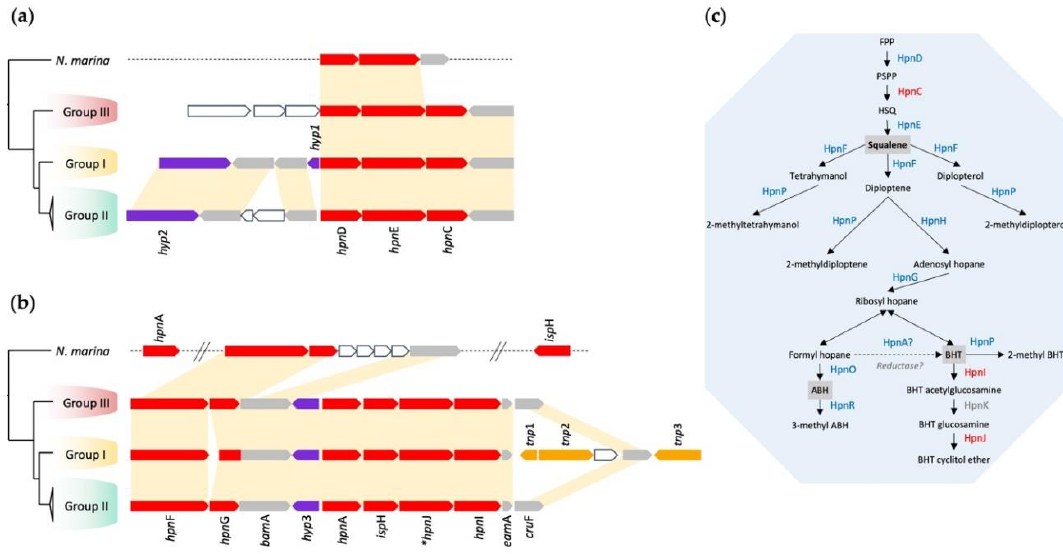
Figure 5. Genomic contexts for genes predicted to participate in ( a ) squalene and ( b ) hopanoid biosynthesis and bacteriohopanetetrol modification. Color coding of genes: red = squalene and hopanoid genes, grey = additional genes whose genomic context is conserved, purple = orphan hypothetical genes, orange = mobile elements and their remnants ( tnp 1-3), and white = other genes. * = hpn J1, hpn J2, and 3 are located in other genome locations. ( c ) Predicted pathways for squalene and hopanoid biosynthesis in Leptospirillum and N. marina . Blue lettering = biosynthetic steps encoded in both Leptospirillum and N. marina , and in red lettering, biosynthetic steps predicted only in Leptospirillum . Abbreviations: BHT = bacteriohopanetetrol, ABH = aminobacteriohopanetriol.